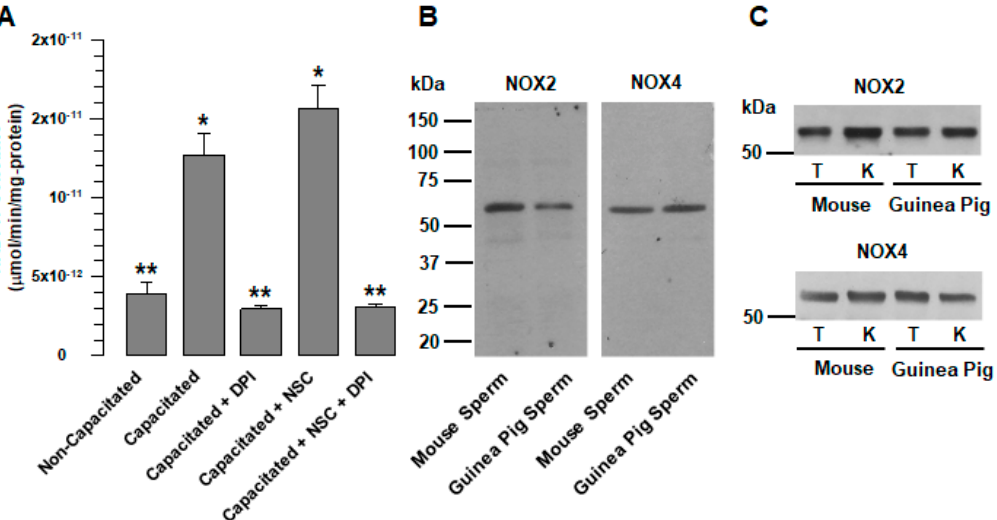
Figure 1. Guinea pig and mouse spermatozoa express two different NOXs. ( A ) Consumption of NADPH in total native protein extracts of guinea pig spermatozoa. The consumption of NADPH was assessed in both non-capacitated and capacitated spermatozoa in the absence and presence of DPI (10 µM) and NSC (NSC23766 100 µM). The results are expressed as the ratio N/N0, where N is the total amount of NADPH that is consumed and N0 is the total quantity of NADPH that is consumed in the non-capacitated assay. The results are expressed as the mean ± S.E. ( n = 3). Differences were considered significant when p ≤ 0.05, comparing (*) concerning (**). ( B ) Detection of NOX2 and NOX4 in guinea pig and mouse spermatozoa. Proteins from whole spermatozoa extracts (300 µg) were resolved by SDS-PAGE and transferred to nitrocellulose membranes. The proteins were detected using specific antibodies against NOX2 and NOX4. MS: Mouse spermatozoa. GPS: Guinea pig spermatozoa. ( C ) Detection of NOX2 and NOX4 in guinea pig and mouse testes and kidneys. Proteins from whole extracts of guinea pig and mouse testes and kidneys were used to determine antibody specificity. T: Testis. K: kidney. Images are representative of three independent experiments. The representative Wb images ( B , C ) of three independent experiments for NOXs detection are shown.